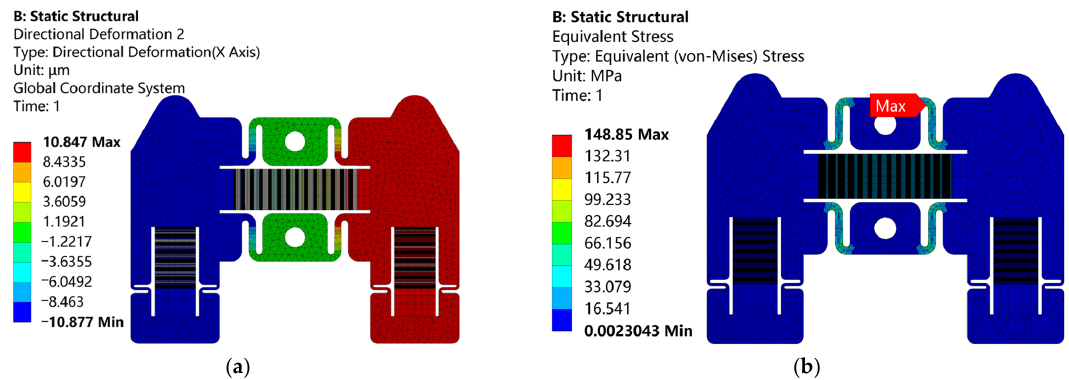
Figure 6. Nephogram of the actuator in static simulation: ( a ) displacement; ( b ) stress.